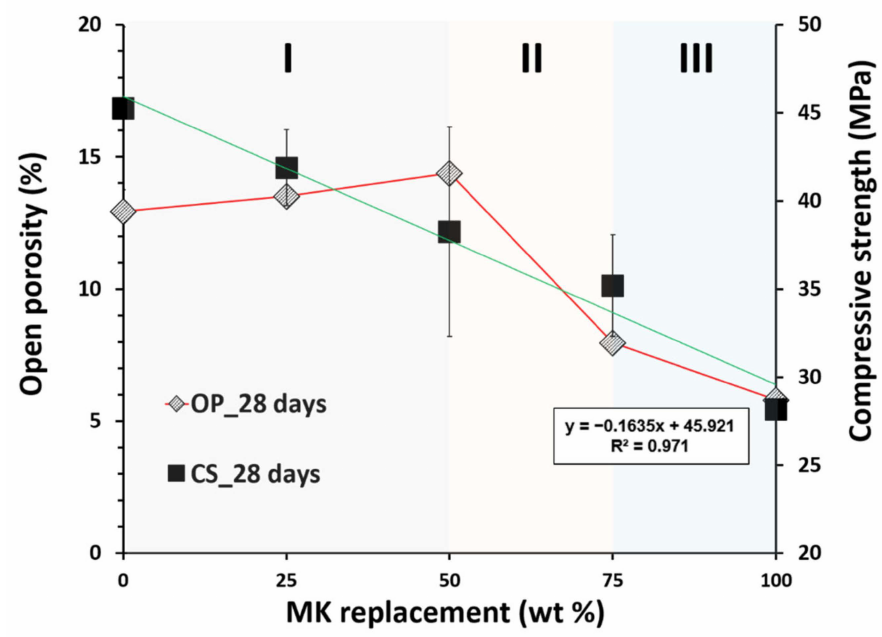
Figure 11. A comparison of the open porosity and compressive strength values of mortars produced with the progressive replacement of metakaolin by local calcined clays after 28 days of curing. I, II and III indicate ranges of MK replacement levels with different relationships between open porosity and compressive